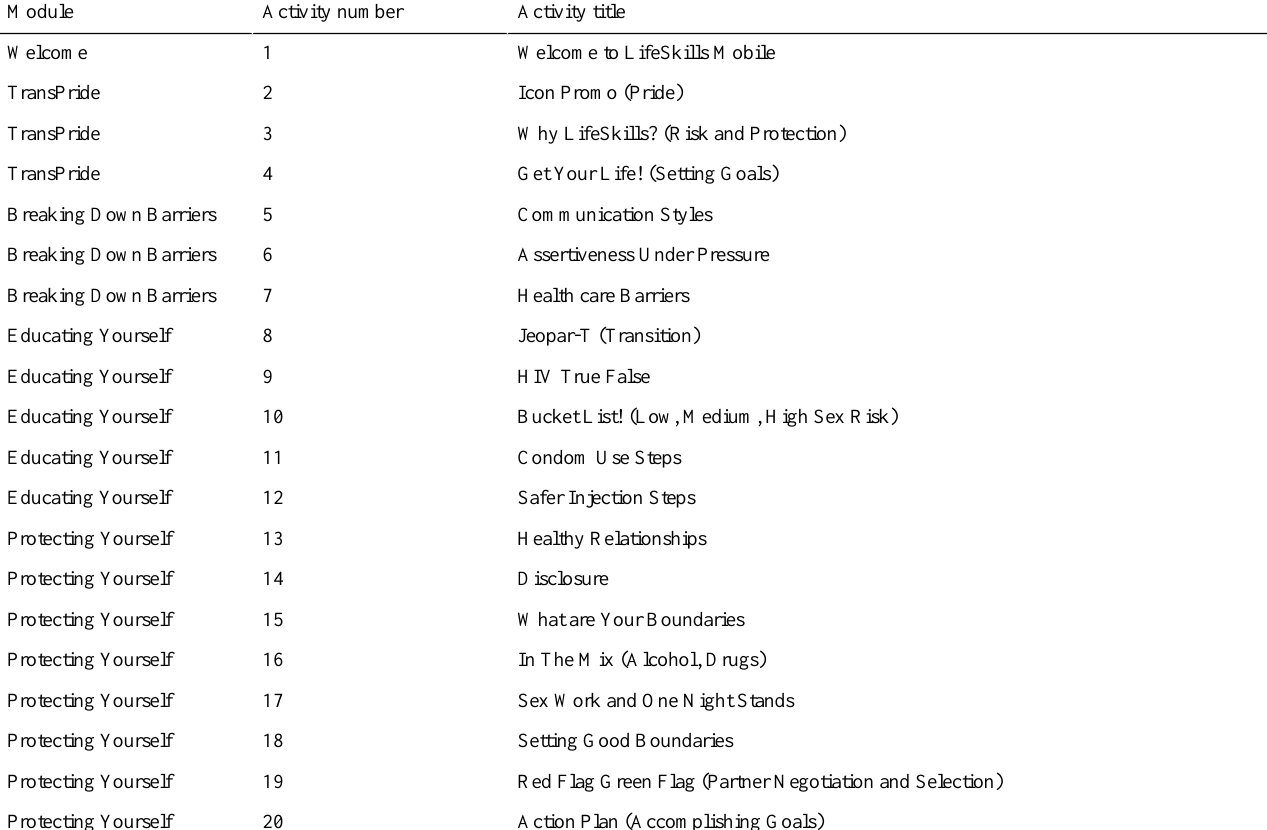
Table 2. LifeSkills Mobile app modules and